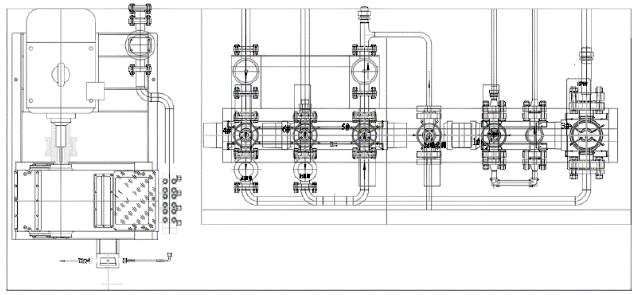
Figure 8. Internal hydraulic loading system.